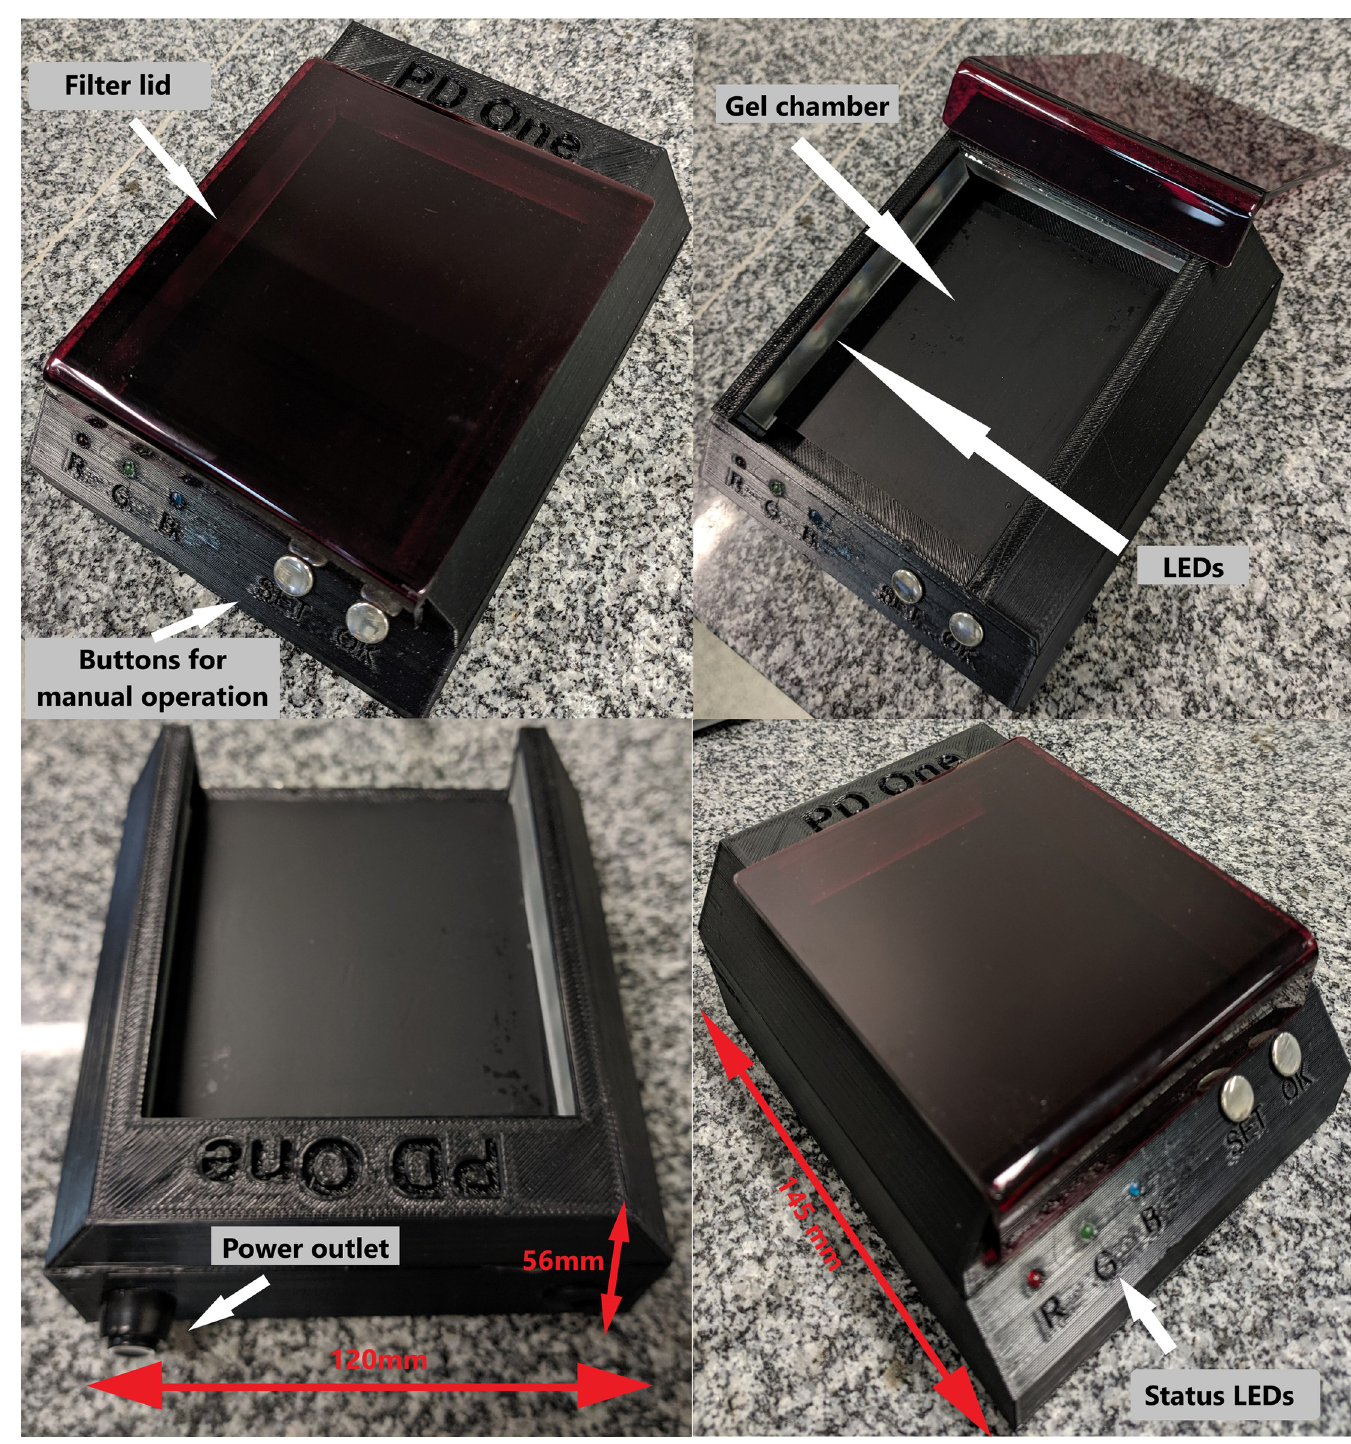
Fig 3. Final assembly of the system after 3D printing. White arrows indicate the filter lid, the status LEDs, the gel chamber, the power outlet, and the "SET" and "OK" buttons for manual operation of the system.